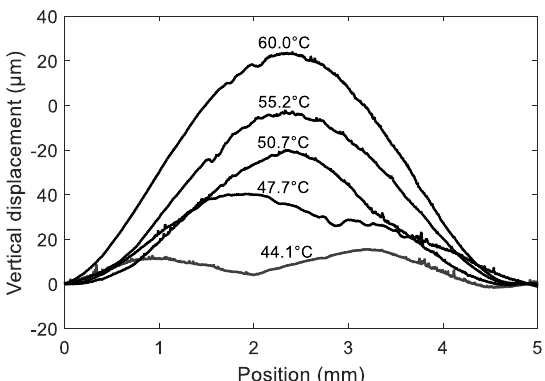
Figure 8. Evolution of the shape of the membrane versus temperature, in the absence of applied pressure (i.e., deformation due to temperature changes only). The measurements were done using a Dektak XT-A Surface Profilometer.